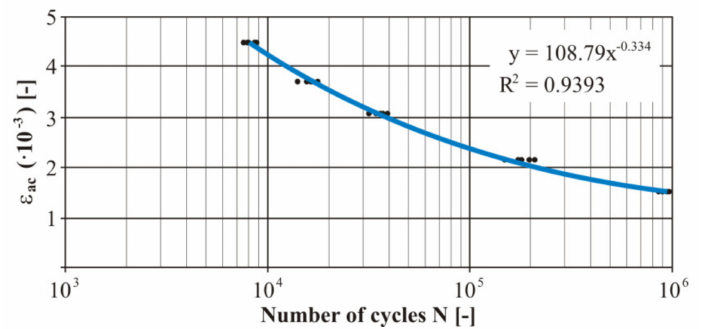
Figure 23. The final Manson − Co ffi n fatigue curve of the basic material EN AW 6063 under the bending load.